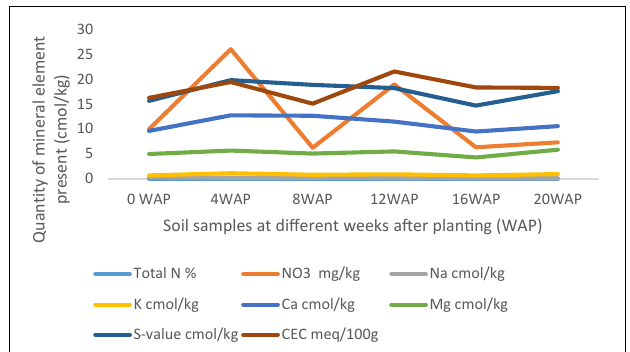
FIGURE 2 | Comparison of different physical and chemical properties of soil samples between 4 and 20 weeks after planting (WAP ). N, nitrogen; K, potassium; Ca, calcium; Na, sodium; Mg, magnesium; S-value shows the mean of the whole graph.